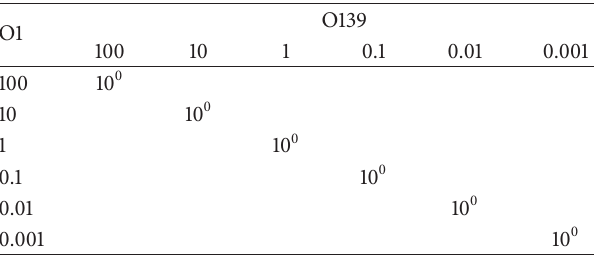
Table 3: The equally reciprocal detection of V . cholerae O1 :O139 by the O serogroup-specific